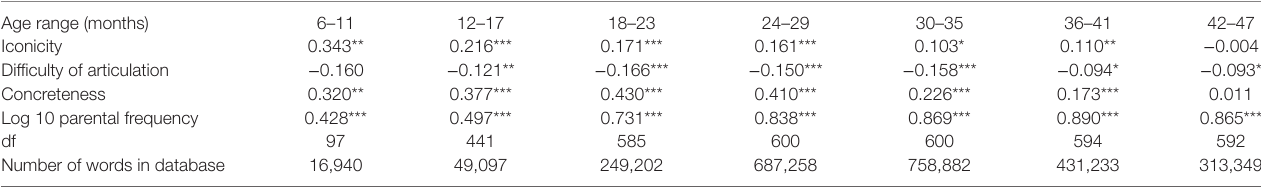
TaBle 4 | Partial correlations and significance values of each of the four independent variables iconicity, difficulty of articulation, concreteness, and log 10 parental input frequency carried out on the log 10 word child frequency at seven different age ranges (in months). Age range